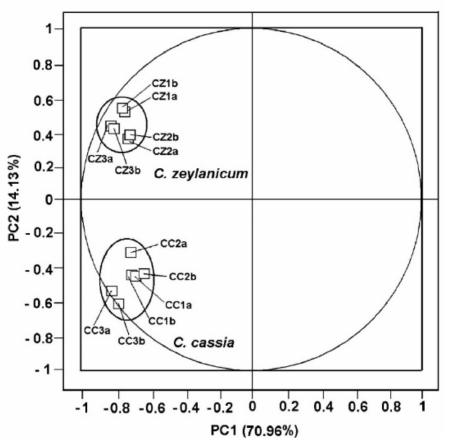
Figure 6. Loading plot obtained by PCA for headspace vapors from ground samples of C. zeylanicum (CZ) and C. cassia (CC). Numbers are used to indicate different cinnamon batches, while letters ( a ) and ( b ) are used to indicate replicate measurements on different portions of the same cinnamon batch. Figure is reproduced from